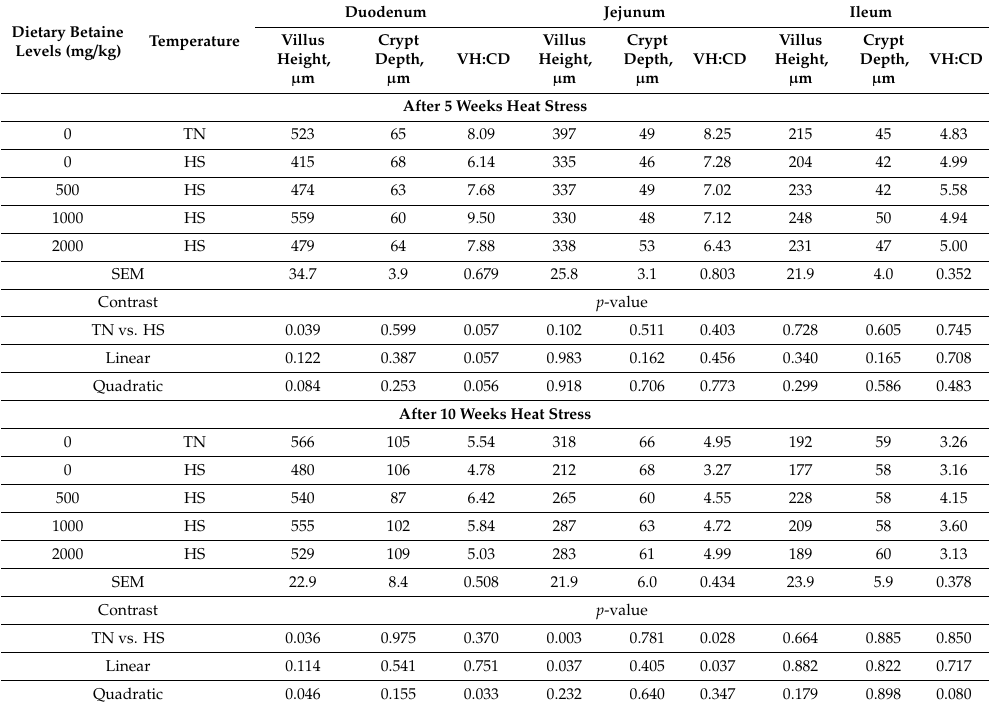
Table 5. Effects of heat stress and dietary betaine on intestinal morphology of yellow-feathered broilers *. Dietary Betaine Levels (mg / kg)